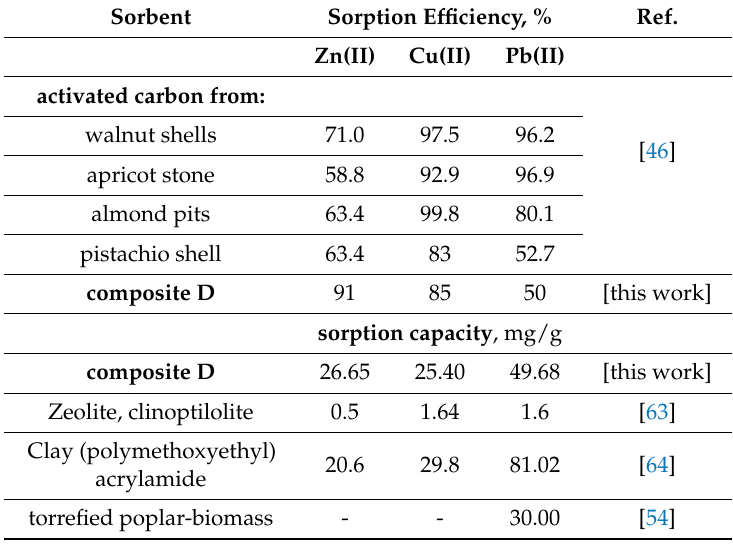
Table 8. Comparison of sorption of Zn(II), Cu(II), Pb(II) ions on composite D with literature data. Sorbent